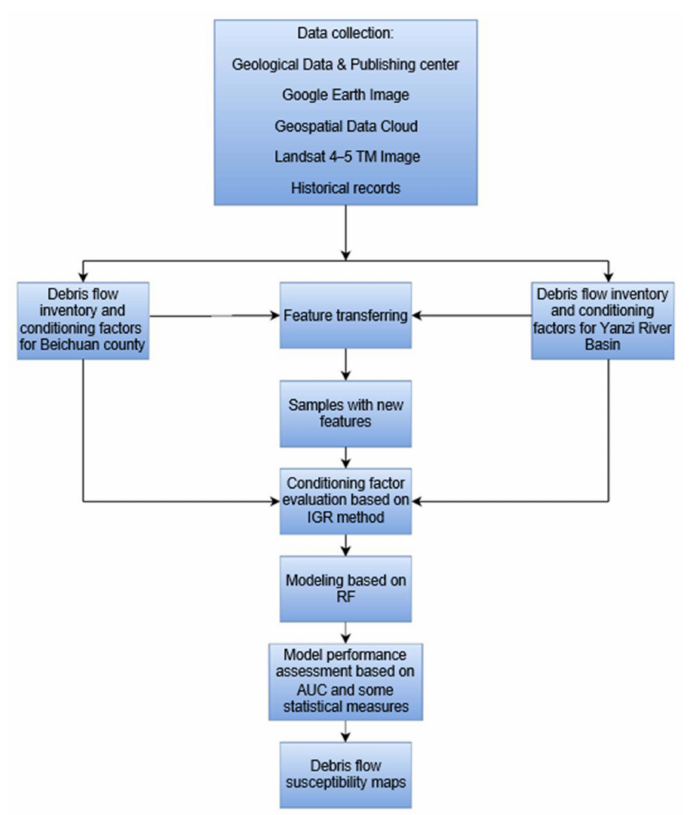
Figure 5. Flow chart of the method in this